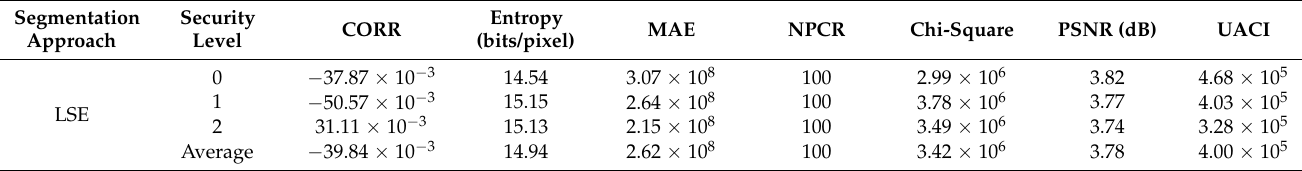
Table 1. Cryptanalysis results of the 60 CBIS-DDSM Mammography DICOM frames for the multi- region encryption